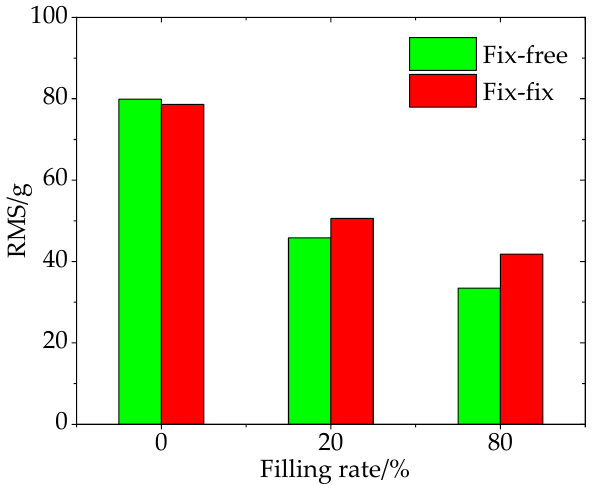
Figure 19. Influence of boundary conditions on vibration reduction effect under three filling rates.